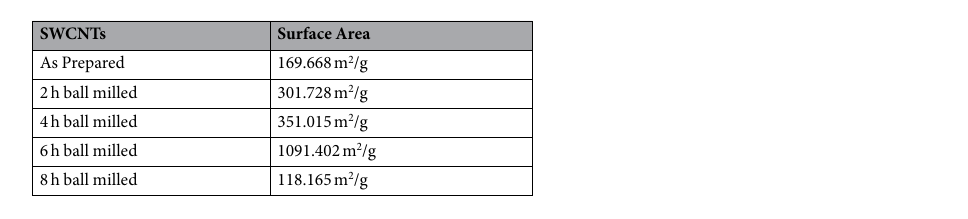
Table 2) serum. Following identification and assessment of relative quantitative differences between protein com- ponents of the BC, we evaluated alterations in the BC due to 1) ball milling (As Prepared vs Ball milled in normal or hyperlipidemic serum), and 2) physiological environment (normal vs hyperlipidemic serum). These com- parisons were determined based on the common processing of SWCNTs by ball milling for manufacturing and